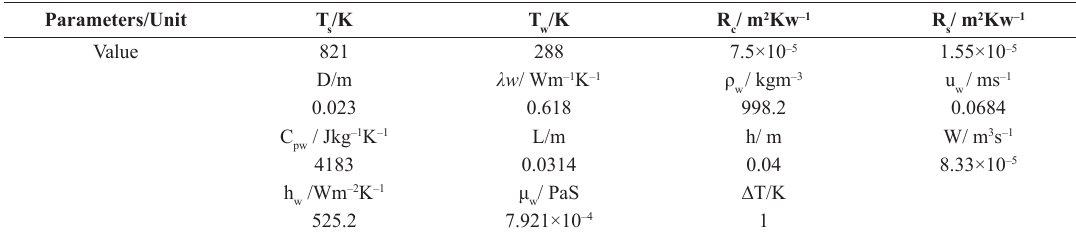
Table 1. The parameters in heat flux density.